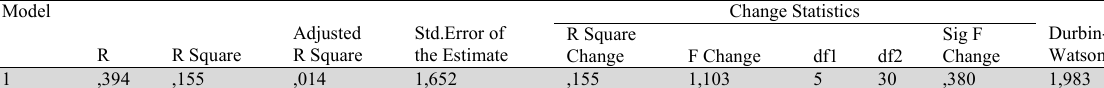
Model summary – Irrational